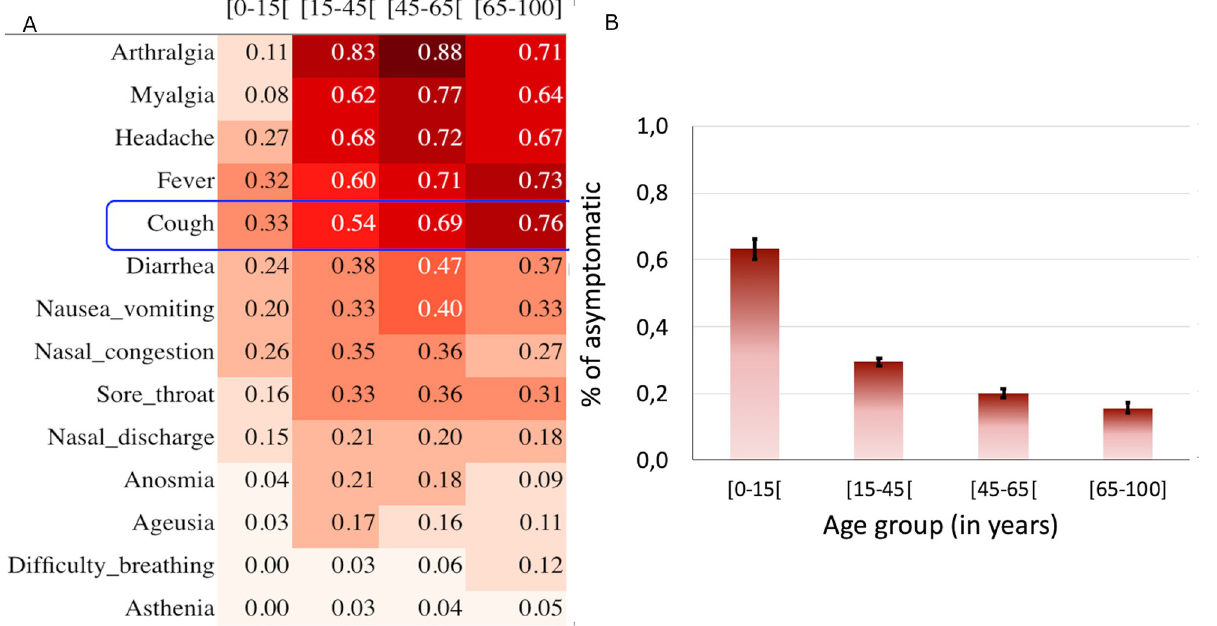
Fig 3. Heatmap of symptom frequency and histogram of asymptomatic patients by age group. A. Heatmap of symptom frequency by age group. Symptoms are listed in rows and age groups in columns. Values in cells indicate the frequency of patients from the corresponding age group manifesting the corresponding symptom. The more the red color is accentuated, the more the symptom is frequent. The blue box targets the "cough" symptom, one of the most involved symptoms in transmission due to the dispersed micro-droplets. This symptom is less frequent in young patients (most active sub-population) compared to adult (less active sub-population). B. Histogram of asymptomatic patients by age group. Black vertical bars represent the standard errors.